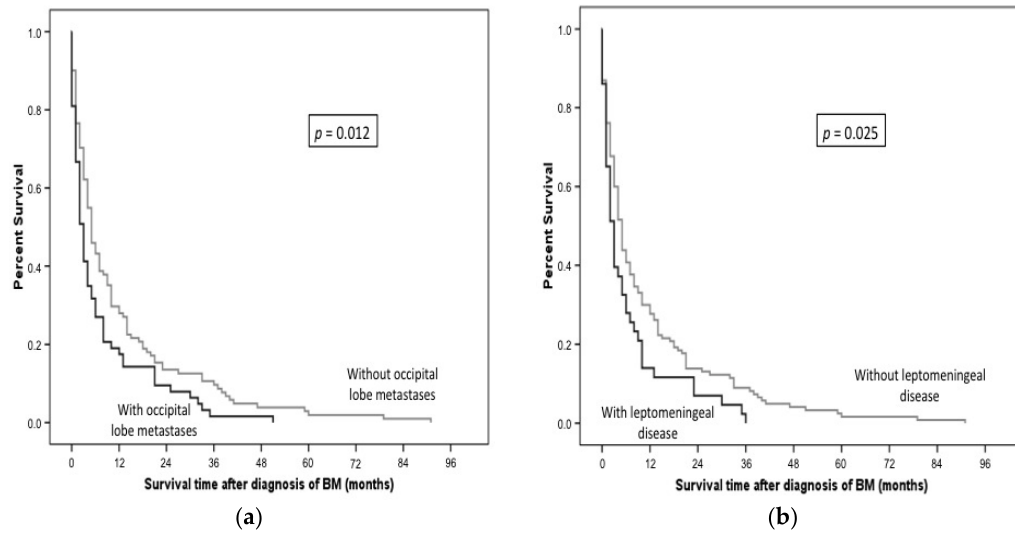
Figure 2. Overall survival depending on BM localization (months). ( a ) Occipital lobe metastases and survival of the patients; ( b ) Leptomeningeal disease and survival of the patients. In multivariate analyses, brain irradiation, neurosurgery, and positive HER2-status of the primary tumor were associated with longer survival after the diagnosis of BMs. Age at diagnosis of BMs was inversely associated with survival: a higher age was associated with an impaired prognosis of patients (Table 3). Table 3. Association between patient characteristics and survival (multivariate analysis) .